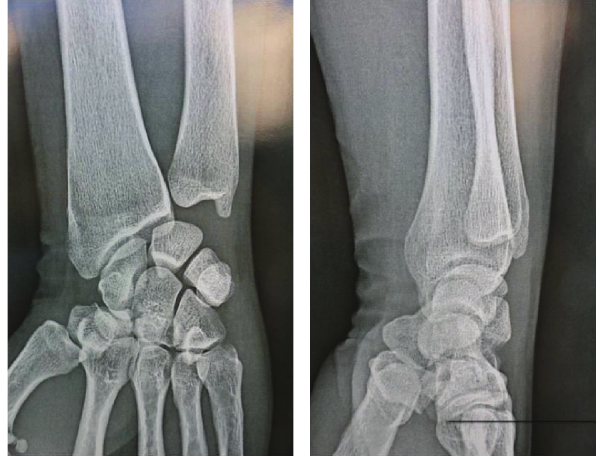
Figure 2: X-ray of the hand shows no bony abnormality.